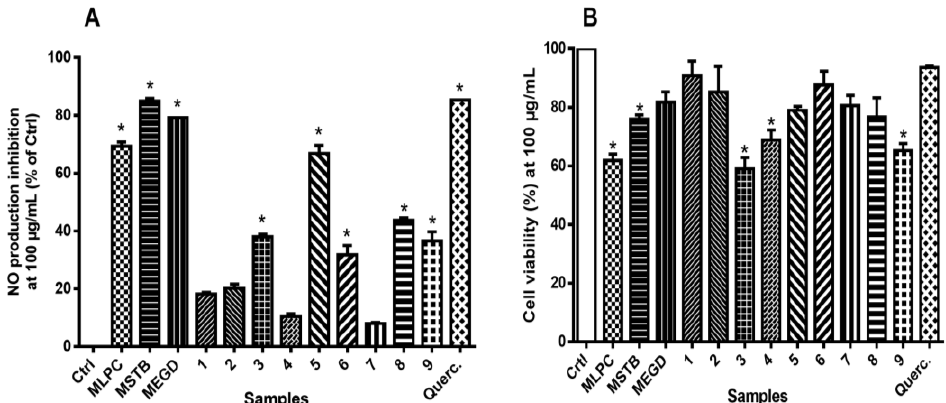
Figure 3. Nitric oxide inhibitory activity of crude extracts and isolated compounds in LPS-stimulated RAW 264.7 macrophage cells ( A ) and their respective percentage of cell viability ( B ). The percentage of NO inhibition was determined based on the efficacy of test samples to inhibit NO production by RAW 264.7 cells compared with the negative control (RAW 264.7 cells treated with LPS and DMSO at 0.5% without test samples), which was considered to be 0% inhibition. Quercetin was used as a positive control. Data represent the mean ± standard deviation of three independent experiments, MLPC: methanol leaf extract of P. capitata , MEGD: methylene chloride/methanol (1:1) entire plant extract of G. dinklagei , MSTB: methylene chloride/methanol (1:1) seed extract of T. bangwensis . Compounds ( 1 – 9 ) were isolated from the above-mentioned plant extracts. Querc. (Quer- cetin). Data are presented as means of triplicate measurements ± standard deviation; (*) means a statistical difference ( p < 0.05) between the tested samples versus the negative control (Crtl).